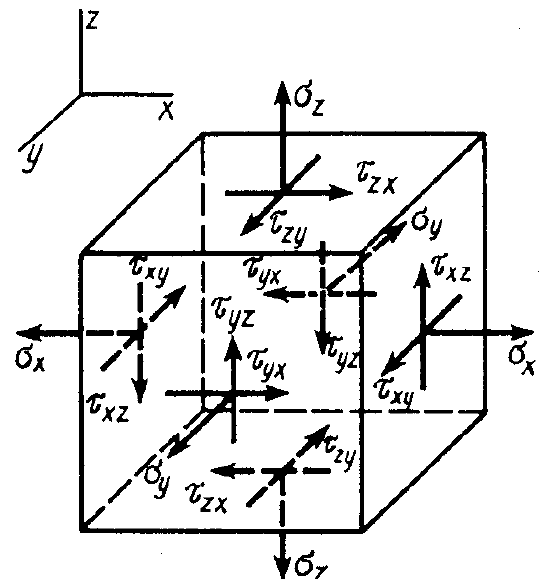
Figure 3. Vibrothermography principle [21].